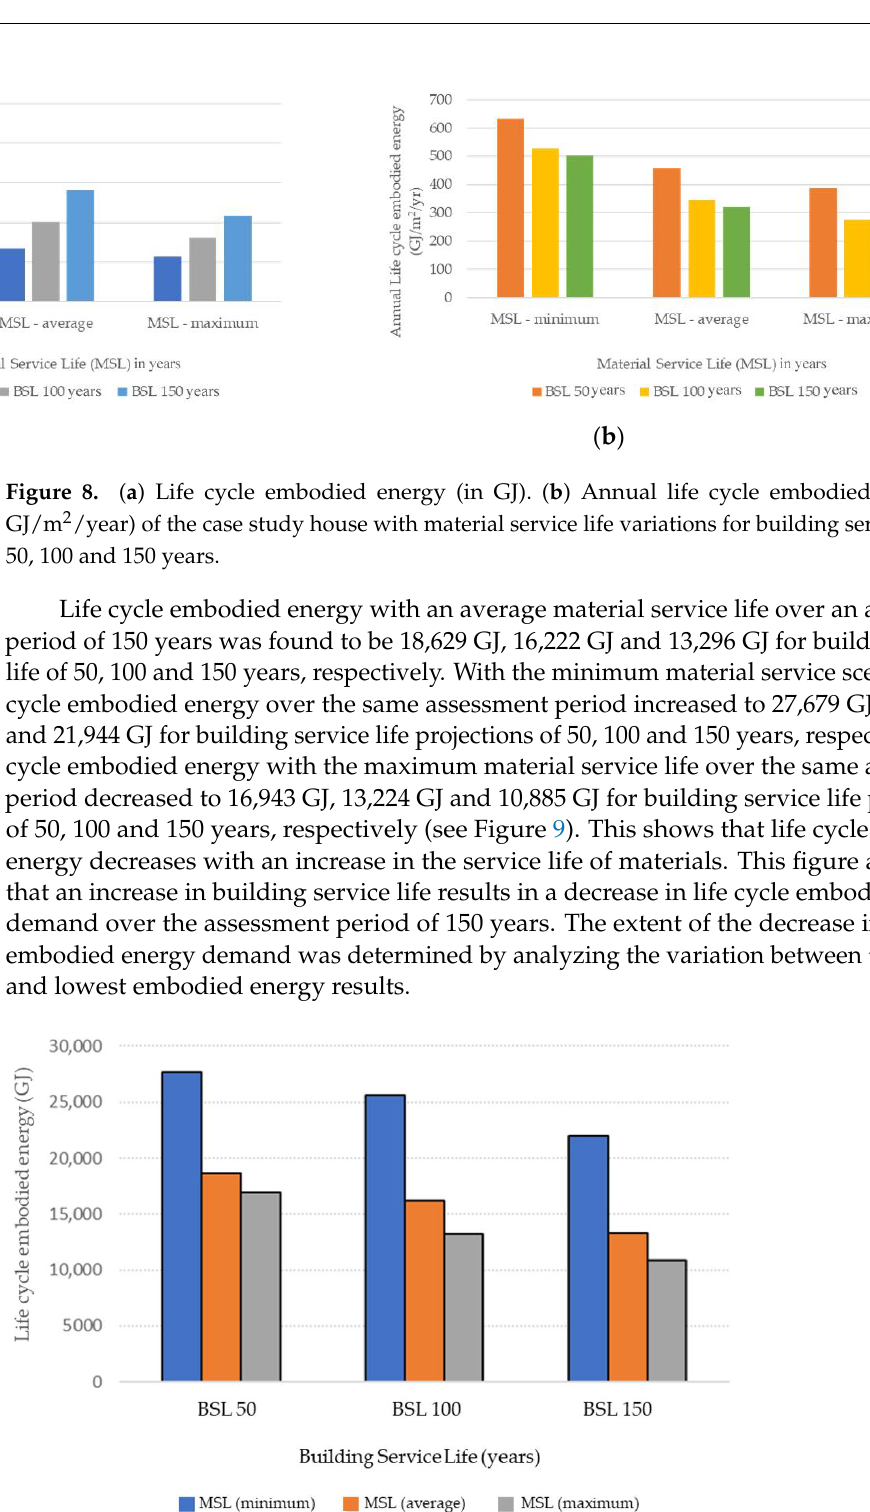
ferences. For minimum values, the life cycle embodied energy was 9226 GJ (632